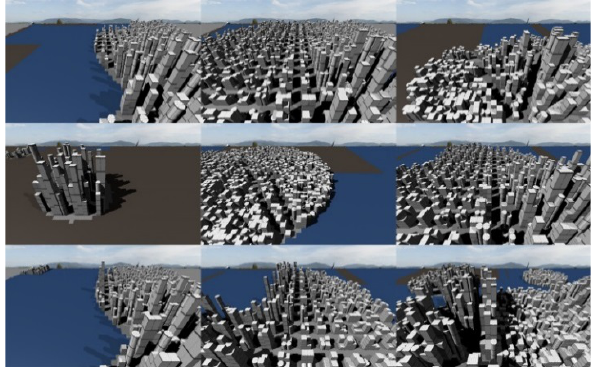
Another 10 generations later, a number of candidates with water appear and high buildings are emerging on the right hand side, and on the left and somewhat smaller buildings on the right hand side. This is shown in Figure 7.